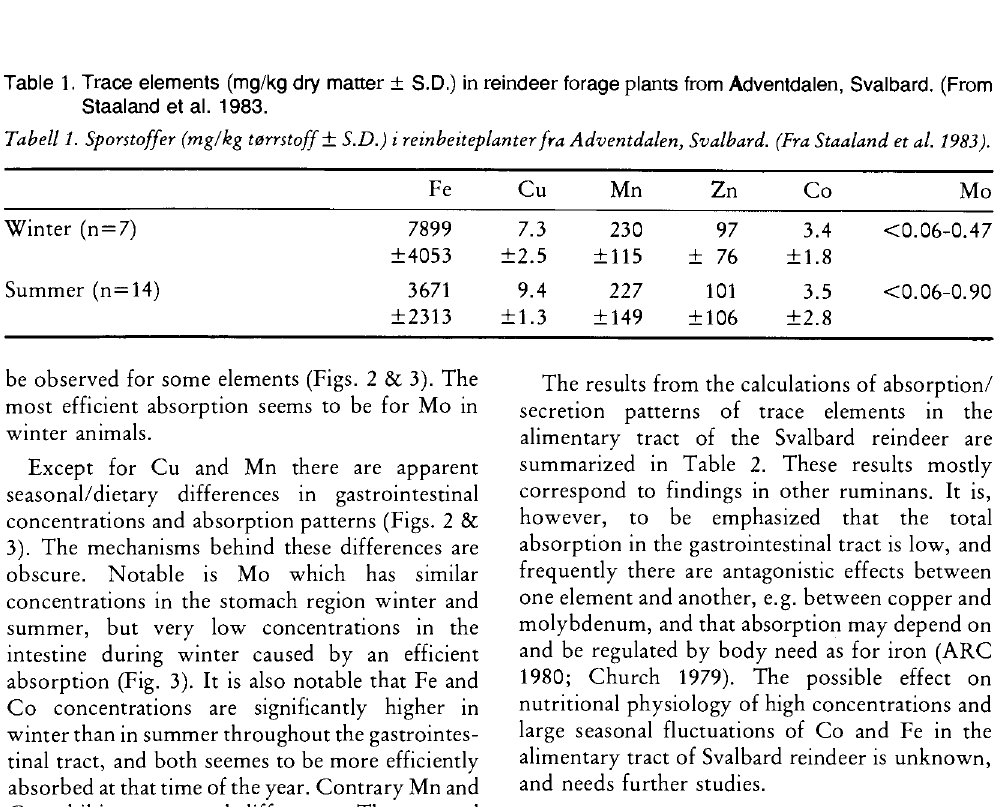
Table 2. Comparison of absorption/excretion patterns of trace elements in the alimentary tract of Svalbard reindeer with the general pattern found in other ruminants. S.I. = small intestine, L.I. = large intestine. Parenthesis = slight indication of